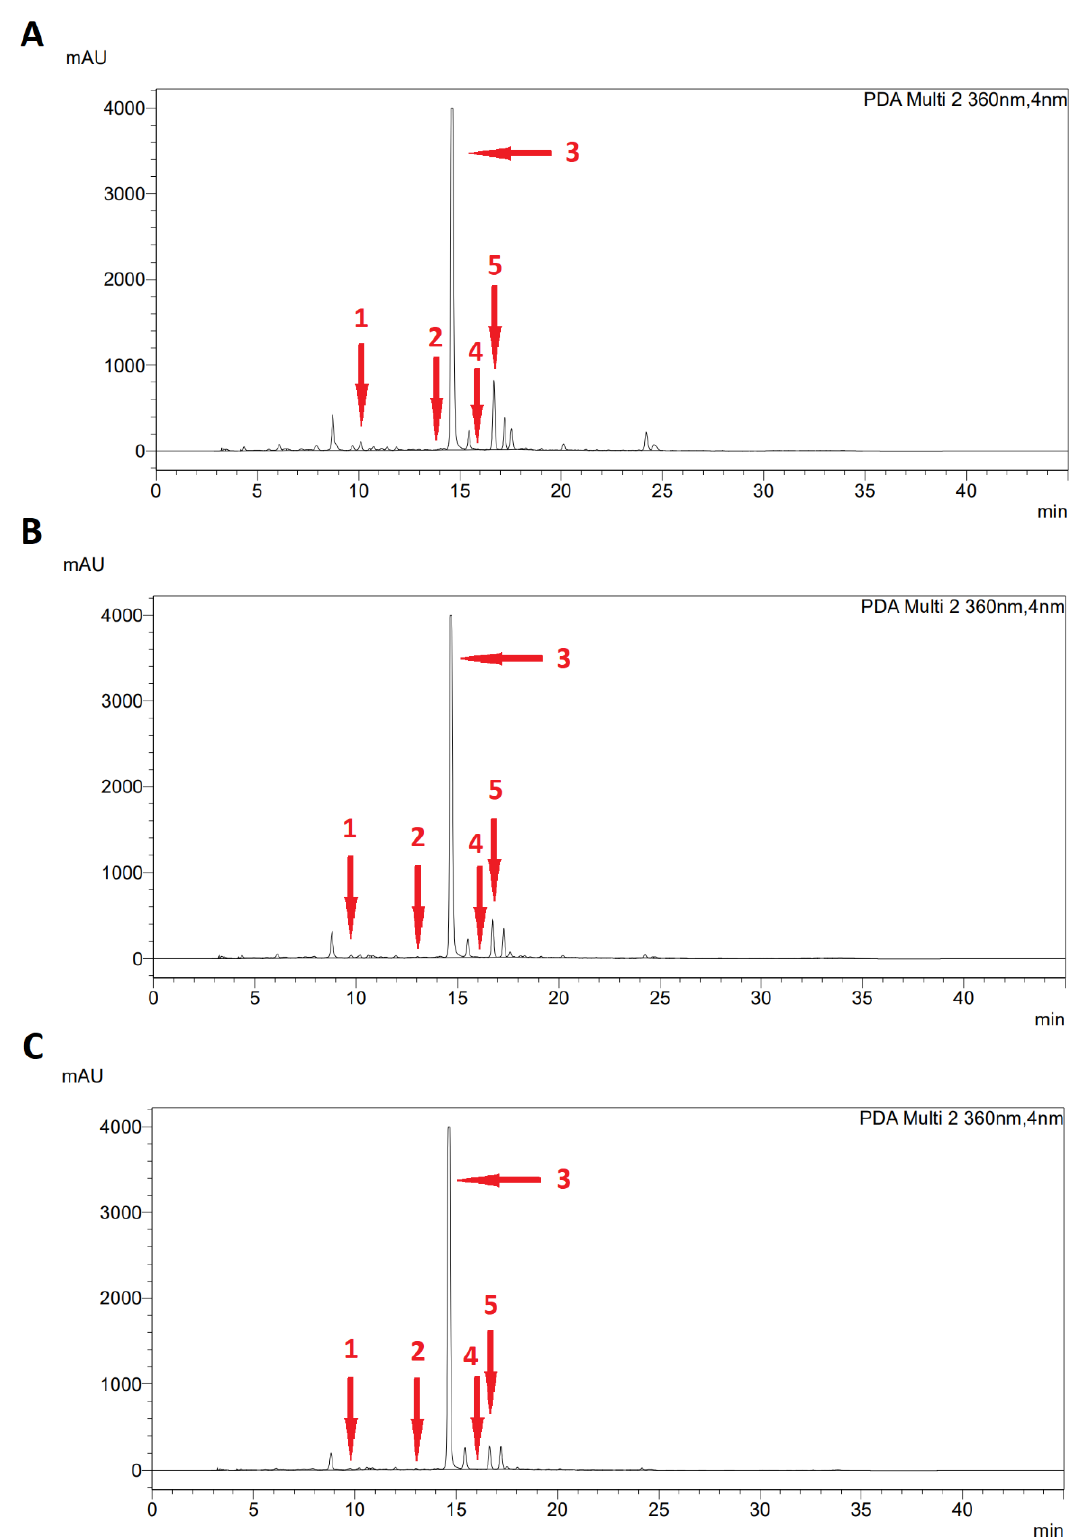
Figure 5. HPLC chromatogram of phenolic compounds profile of Sida hermaphrodita L. recorded at 360 nm, at ( A ) pre-flowering, ( B ) flowering, and ( C ) end of flowering stage; 1 — caffeic acid, 2 — coumaric acid, 3 — ellagic acid, 4 — ferulic acid, and 5 — naringin.